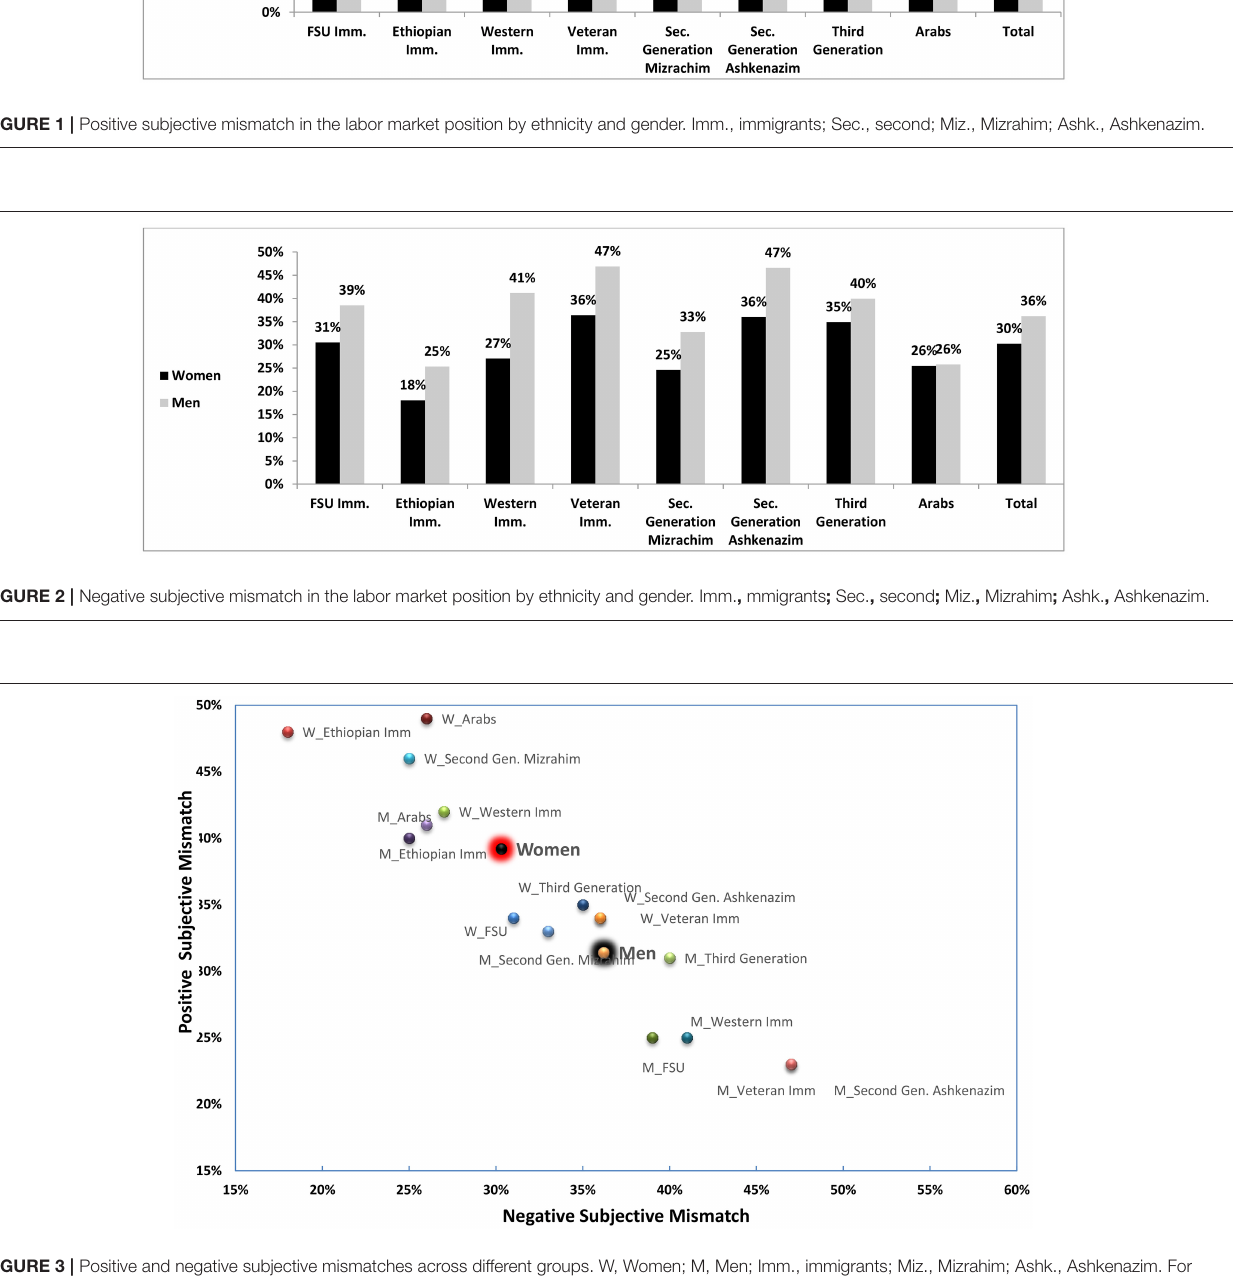
Frontiers in Sociology | www.frontiersin.org